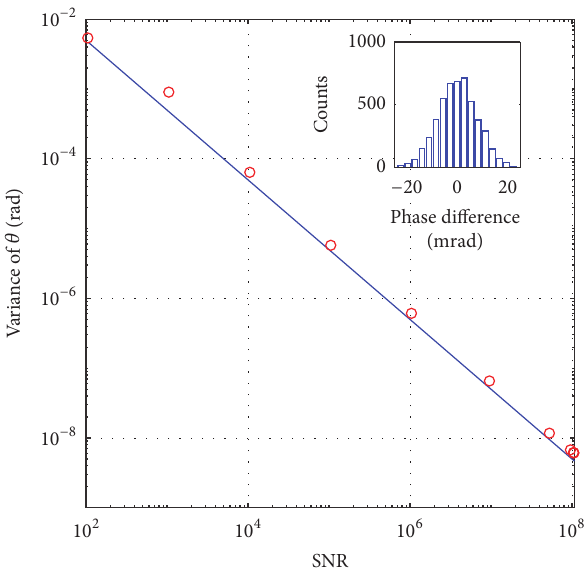
Figure 7: Simulation of the phase variance of the OCT signal (cir- cles) as a function of SNR compared to the theoretical predication of (47) (solid line). The inset shows the histogram of the phase distribution of the OCT signal at 𝑟 𝑟 = 10 −2